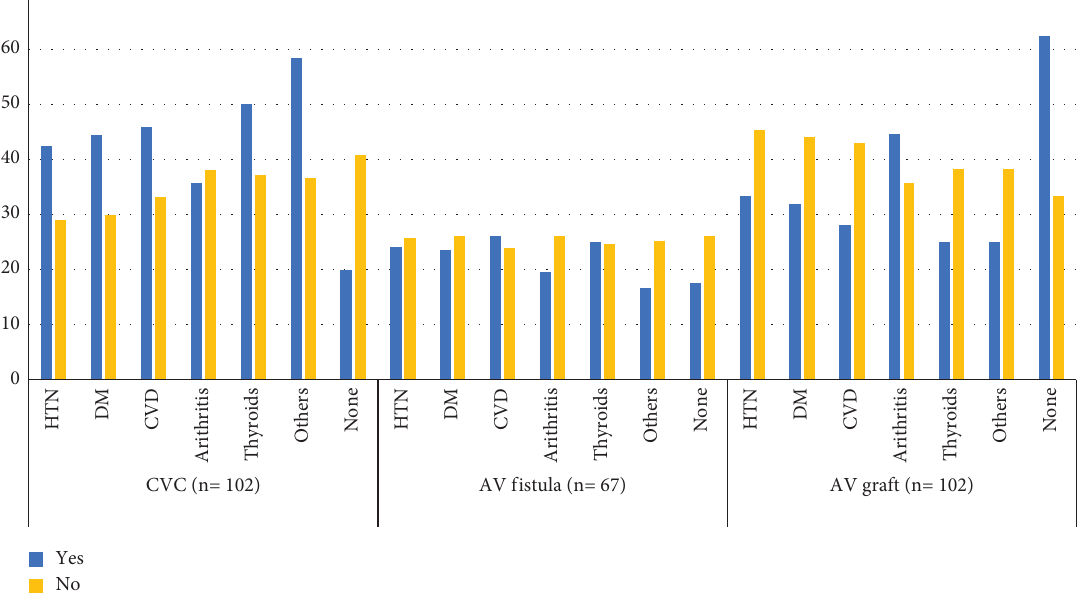
Figure 1: Access port distributions among comorbid patients. ( N � 271) (CVC: central venous catheter, AV fstula: arteriovenous fstula, AV graft: arteriovenous graft, HTN: hypertension, DM: diabetes mellitus, CVD: cardiovascular diseases). Table 2: Te mean scores for each subject of the 3 mean domains of the KDQOL-SF36 instrument among studied HD (hemodialysis) patients ( N � 271).